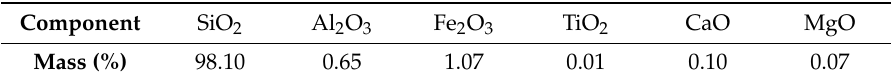
Table 1. Chemical composition of silica sand.